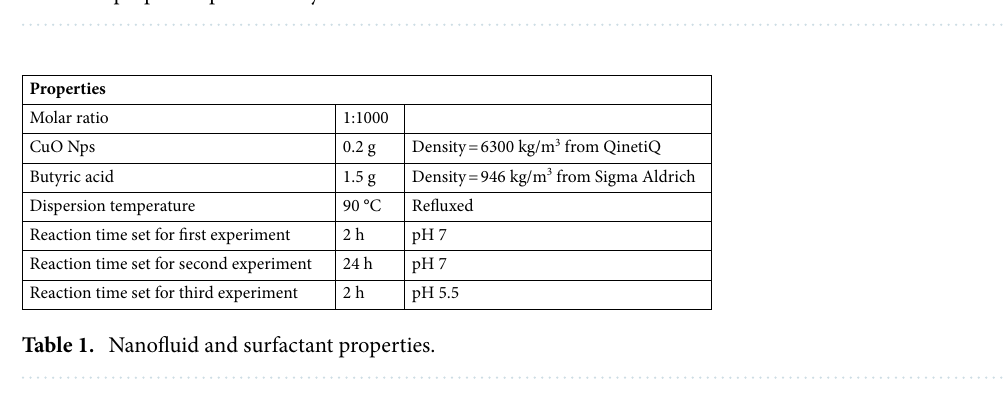
Figure 2. CuO nanoparticle image ( a ) observed by TEM. The average size of the nanoparticles is approximately 50 nm (Xu et al. 27 ). The CuO crystal structure is shown in the upper-right corner, ( b ) CuO++ structure and its structural properties produced by Material Studio.